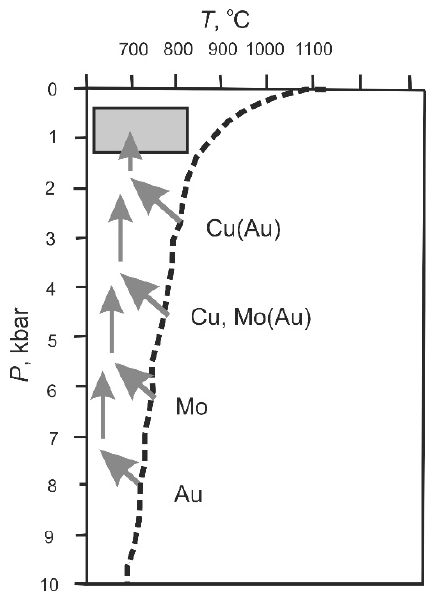
Figure 11. Hypothetical dependence of the type of porphyry deposits on the depths at which the mineralizing fluids separated form granitoid magma chamber. Arrows–mineralizing fluids, gray rectangle–area of deposition of ore mineralization. Dotted line–water saturated granite solidus [17].